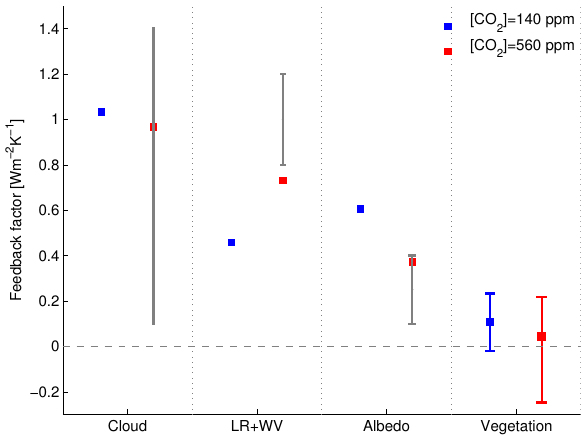
Fig. 11. Global feedback factors for cloud, lapse rate (LR) plus water vapour (WV), albedo and vegetation for experiments with 140ppm (blue), and 560ppm (red). The filled squares indicate the ensemble median. For the vegetation feedback, the bars show the range from the ensemble. For the fast feedbacks, the errorbars rep- resent the inter-model range from the AR4 models from Soden and Held